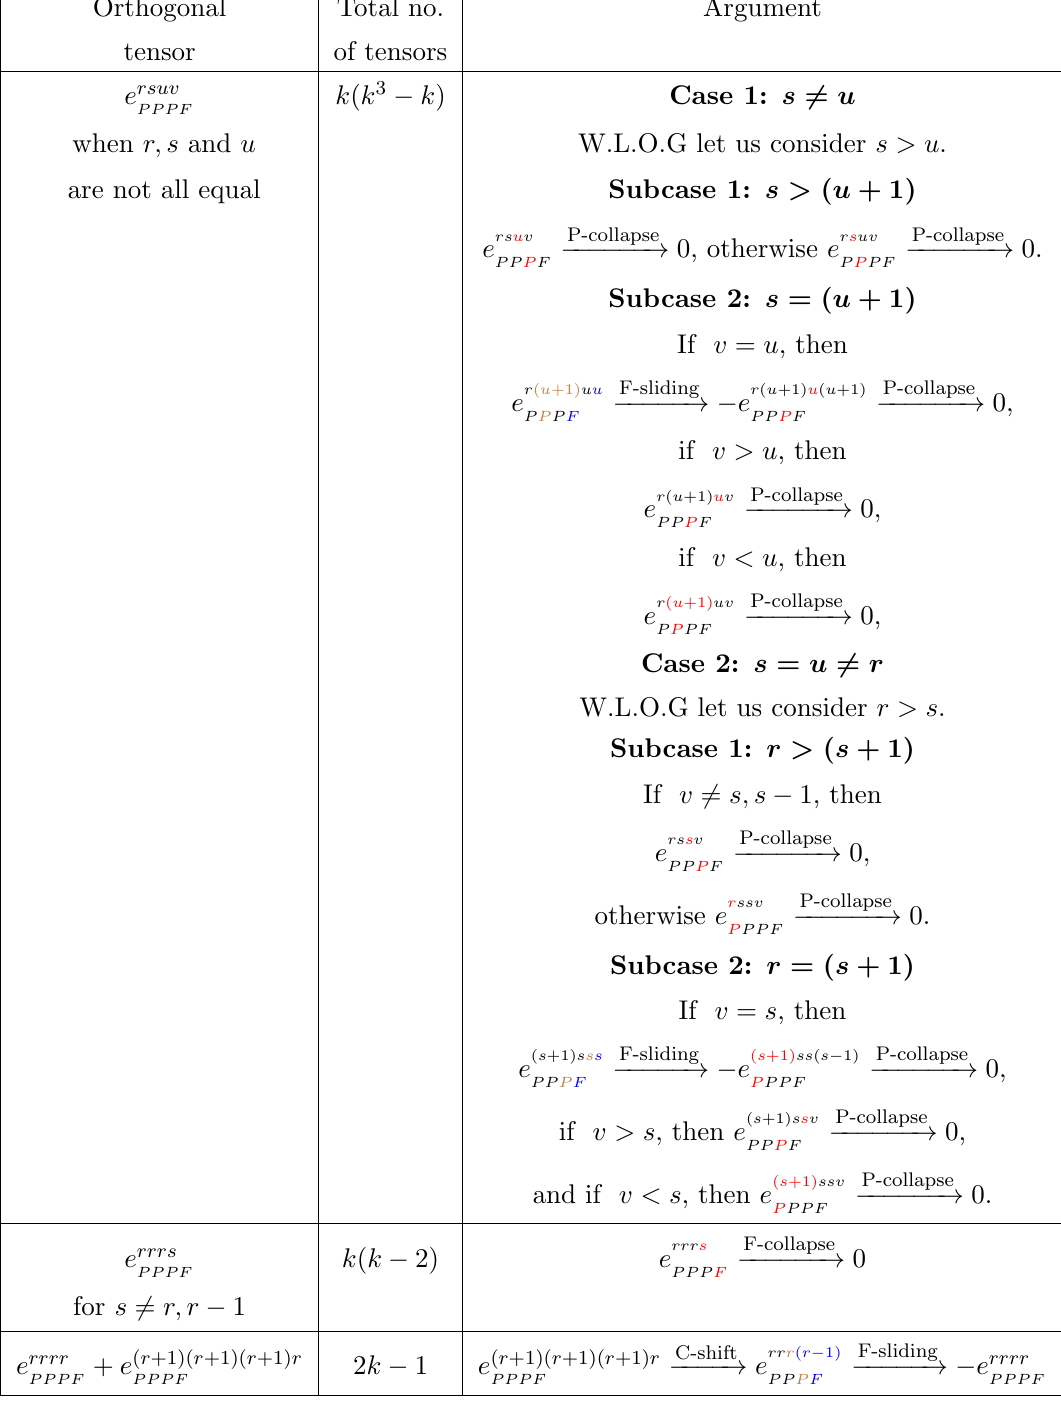
Table 6 . Arguments for the tensors in the PPPF sector orthogonal to the array of 4 point contour